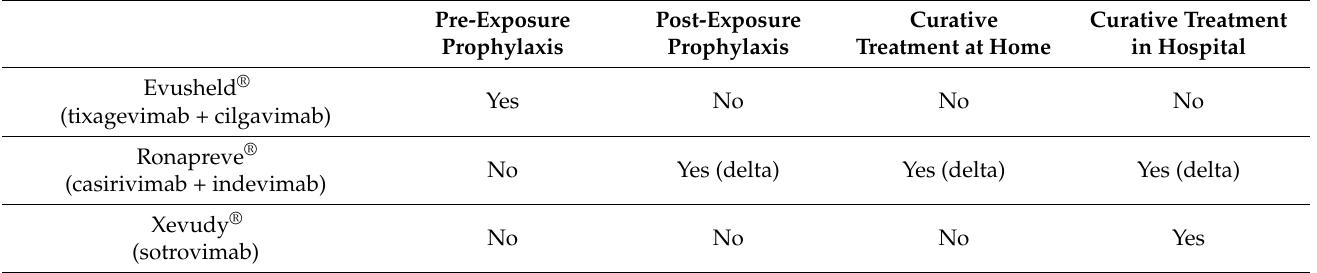
Table 1. Recommendations for the use of therapeutic monoclonal antibodies available in